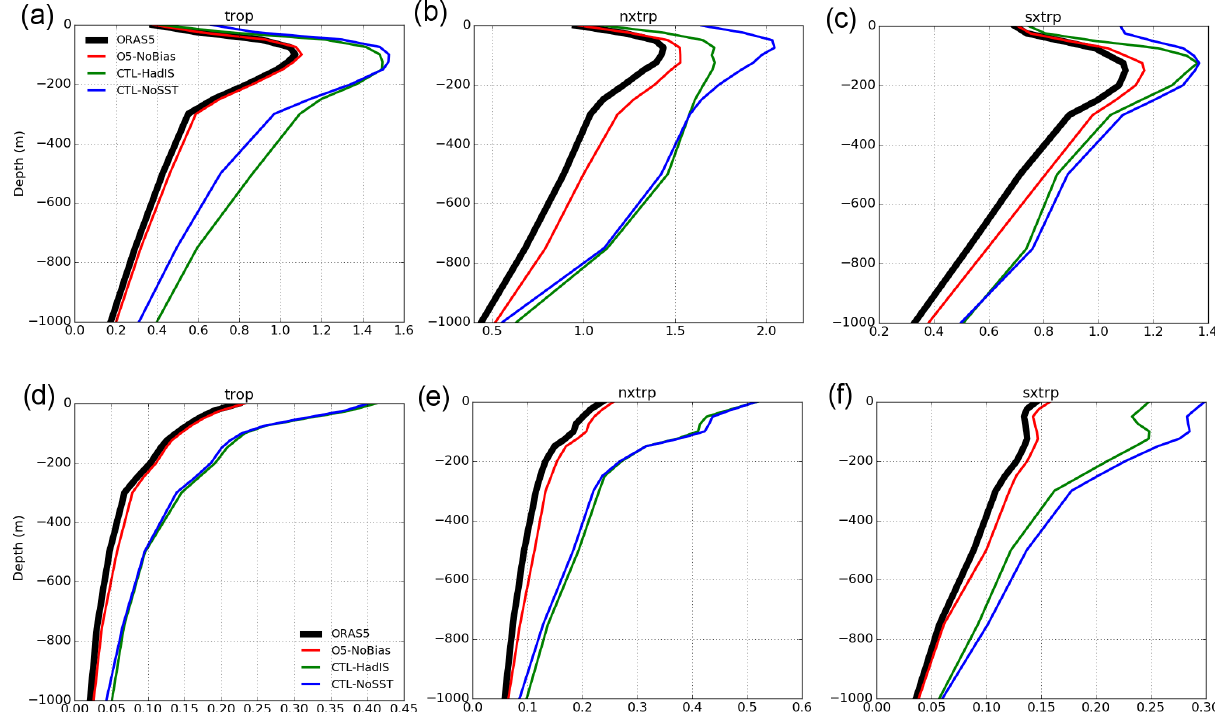
Figure 17. Vertical profiles of model fit-to-observation RMSEs in (a, b, c) temperature (K) and (d, e, f) salinity (psu), averaged over (a, d) tropics (30 ◦ S to 30 ◦ N, trop), (b, e) northern extra-tropics (30 to 70 ◦ N, nxtrp) and (c, f) southern extra-tropics (30 to 70 ◦ S, sxtrp), and over the 2005–2014 period for ORAS5 (black), O5-NoBias (red), CTL-HadIS (green) and CTL-NoSST